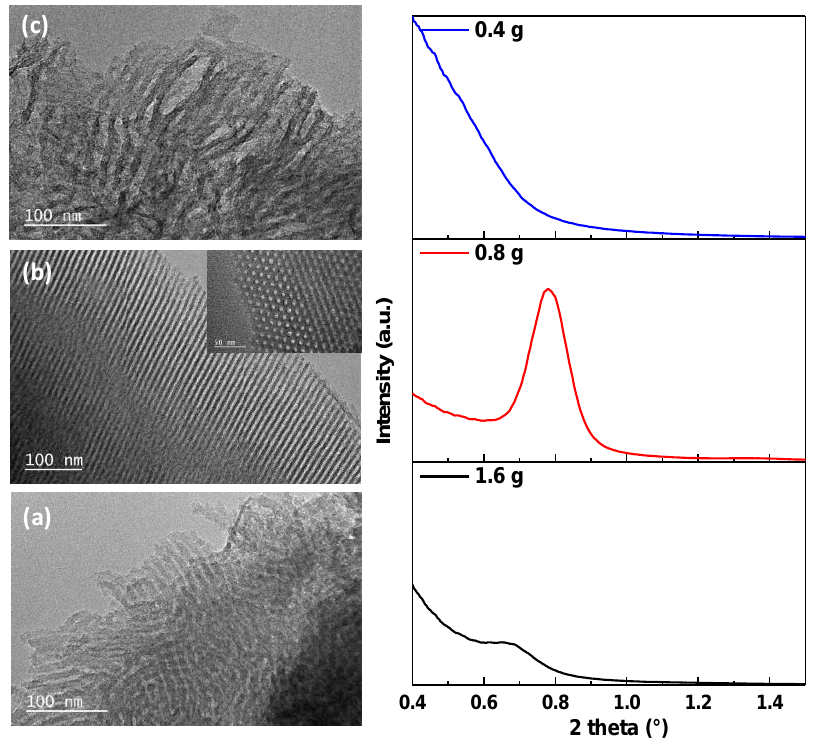
Figure 4. ( left ) TEM images of carbon materials and ( right ) Small-angle X-ray Scattering patterns of carbon materials obtained using the stirring procedure and different amounts of template: 1.6 g ( a ), 0.8 g ( b ) and 0.4 g ( c